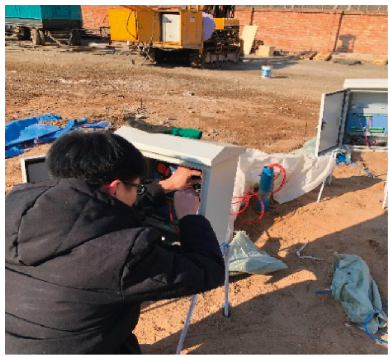
Figure 7: Data acquisition